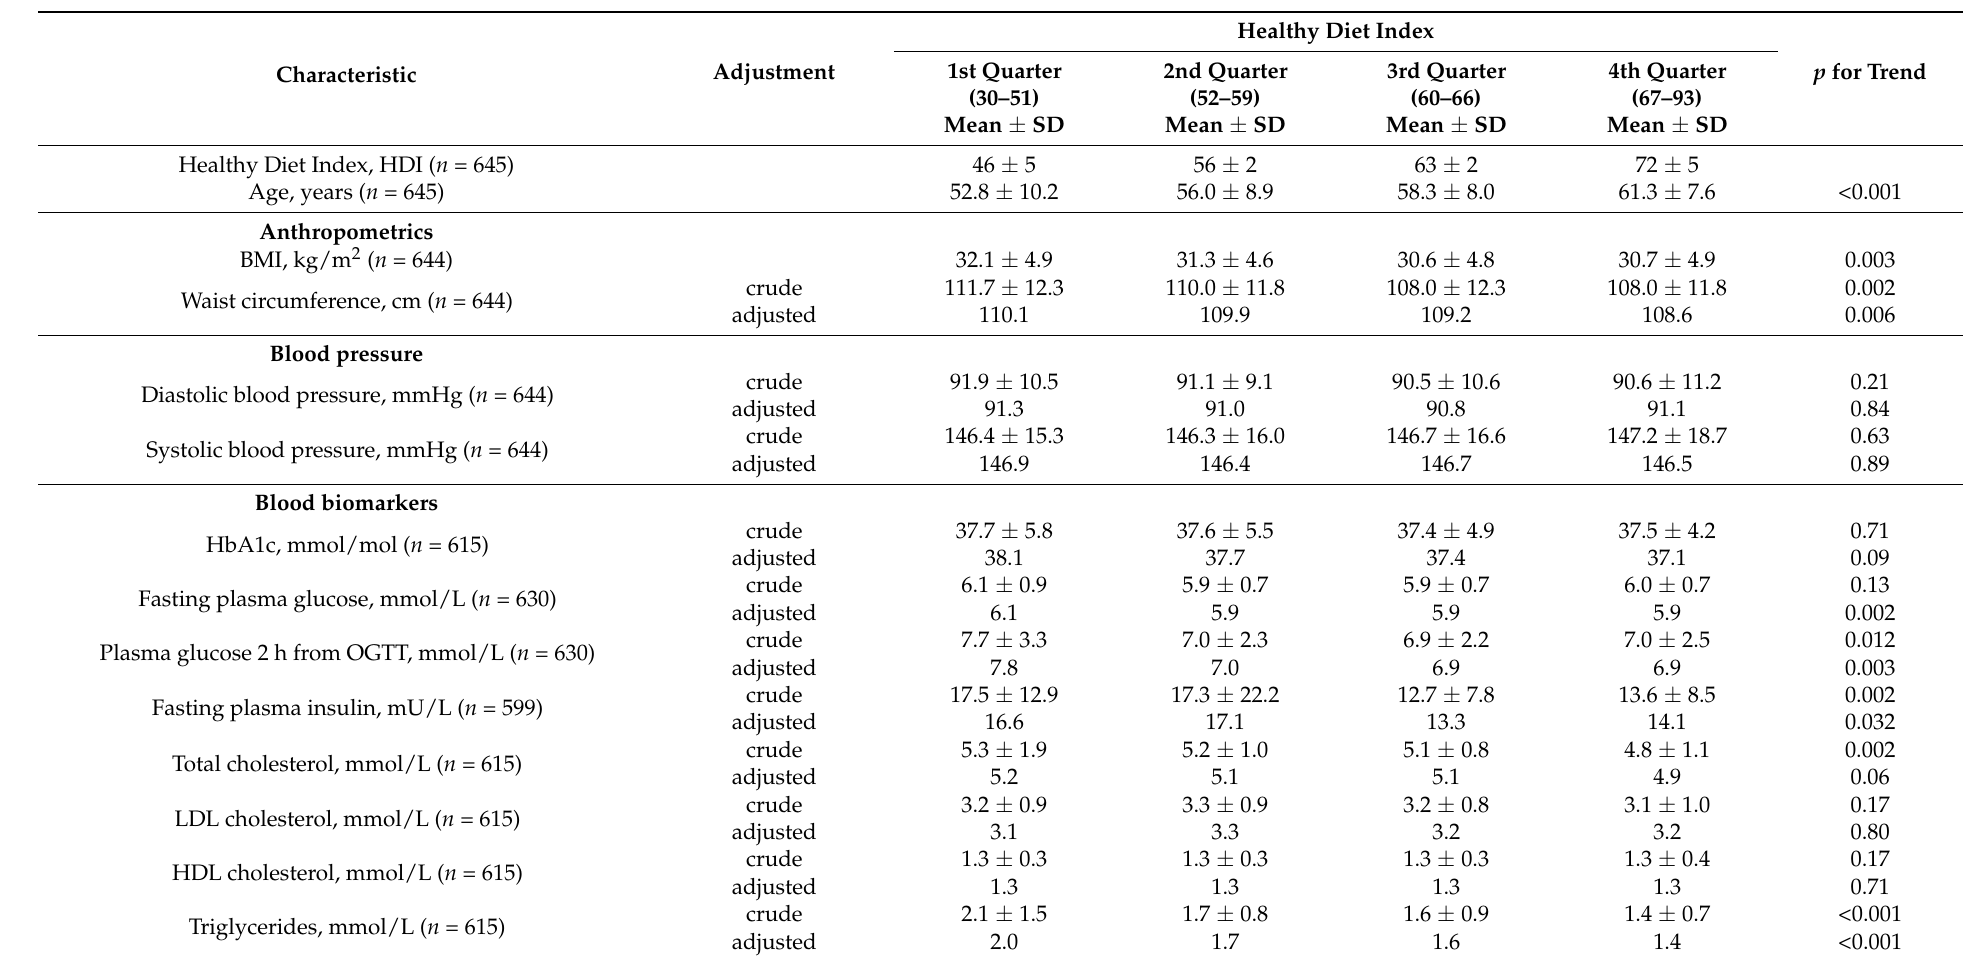
Table 4. Association between Healthy Diet Score and age, anthropometrics, blood pressure, and biomarkers (crude and age- and BMI-adjusted) among men in StopDia data.